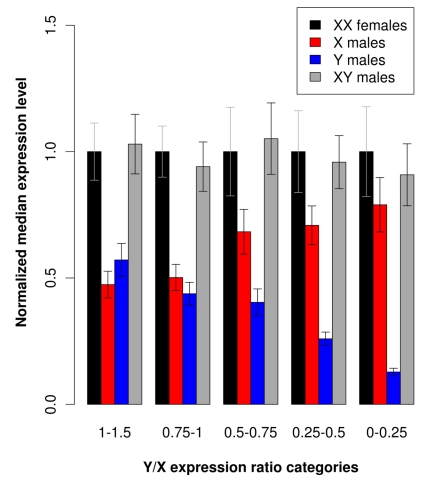
Expression levels of sex-linked contigs in both sexes for different Y/X expression ratio categories.Total read numbers were summed at sex-linked SNP locations and normalized for each individual and contig separately; medians for all contigs and individuals of the same sex were then obtained. Contigs with Y/X expression ratios above 1.5 were excluded, as well as contigs with Xmale/2Xfemale ratios above 2 (see text for explanations), which reduces the dataset to 1,346 sex-linked contigs. XX females, median expression level of both X-linked alleles in females; X males, median expression level of the single X-linked allele in males; Y males, median expression level of the Y-linked allele in males; XY males, median expression level of the X-linked plus Y-linked alleles in males. To compare different Y/X expression ratio categories, medians were normalized using the XX expression levels in females. Sample sizes are: 0–0.25, 110; 0.25–0.5, 269; 0.5–0.75, 315; 0.75–1, 341; 1–1.5, 315. Note that we do not have any contig with Y/X = 0 as our method did not allow us to detect such contigs (see Material and Methods). Error bars indicate 95% confidence intervals.